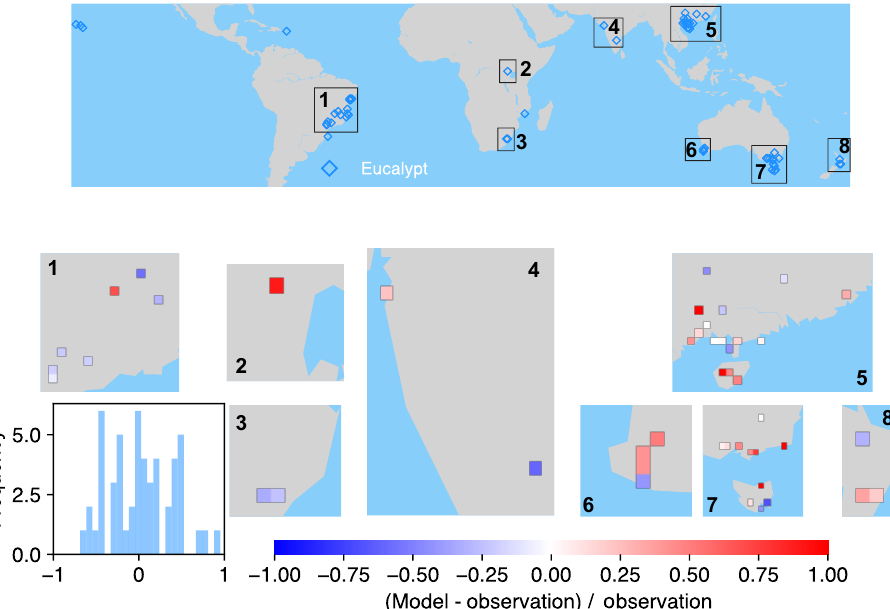
Figure 6. The map of relative difference between simulated and observed biomass yields for PFT14 (tropical bioenergy tree, eucalypt). The inset plot shows the frequency of the relative difference between the model and